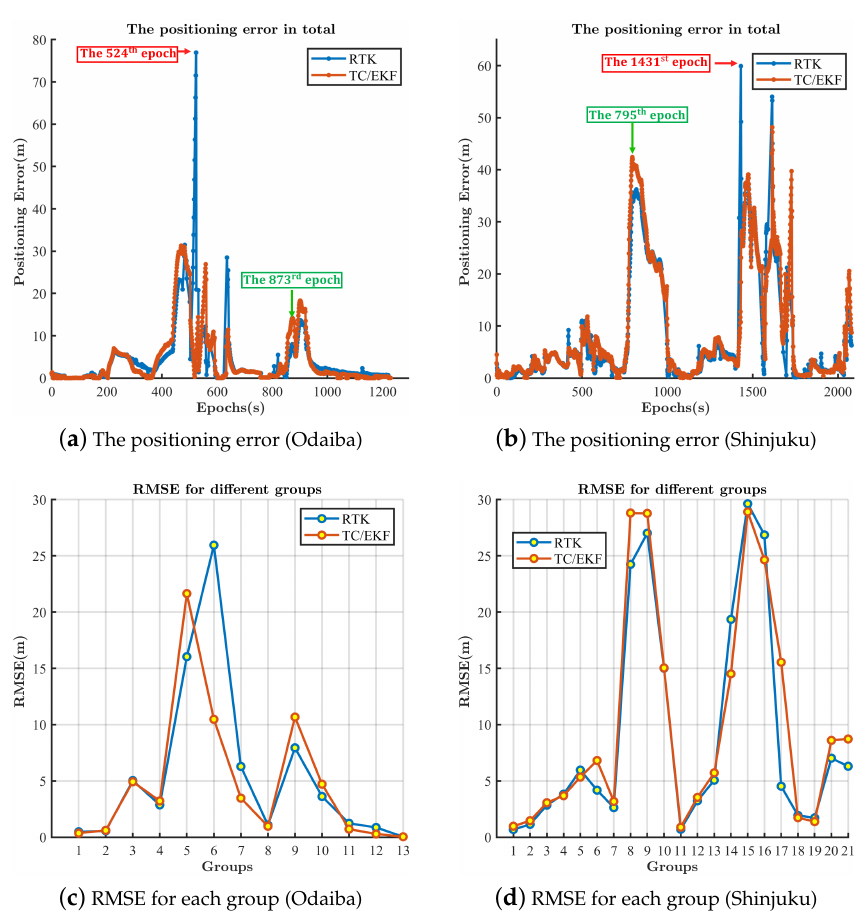
Figure 8. The positioning accuracy comparison between RTK and the TC RTK/INS